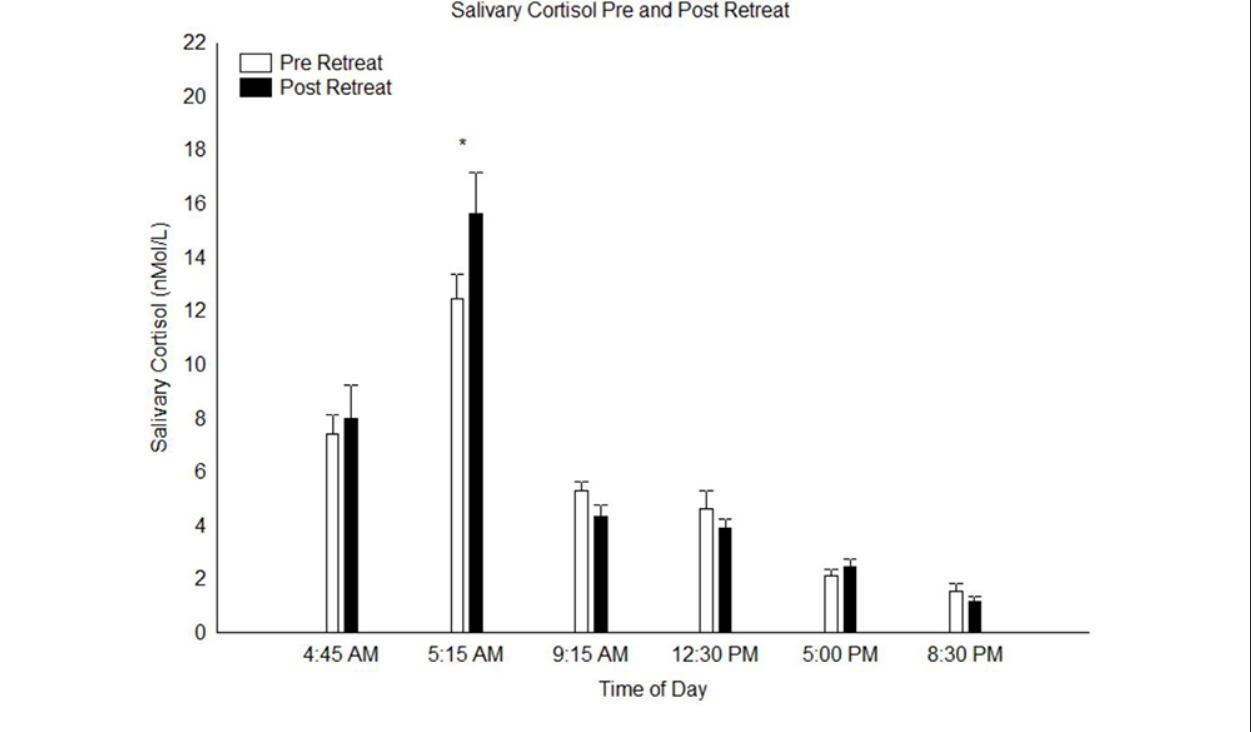
Frontiers in Human Neuroscience |